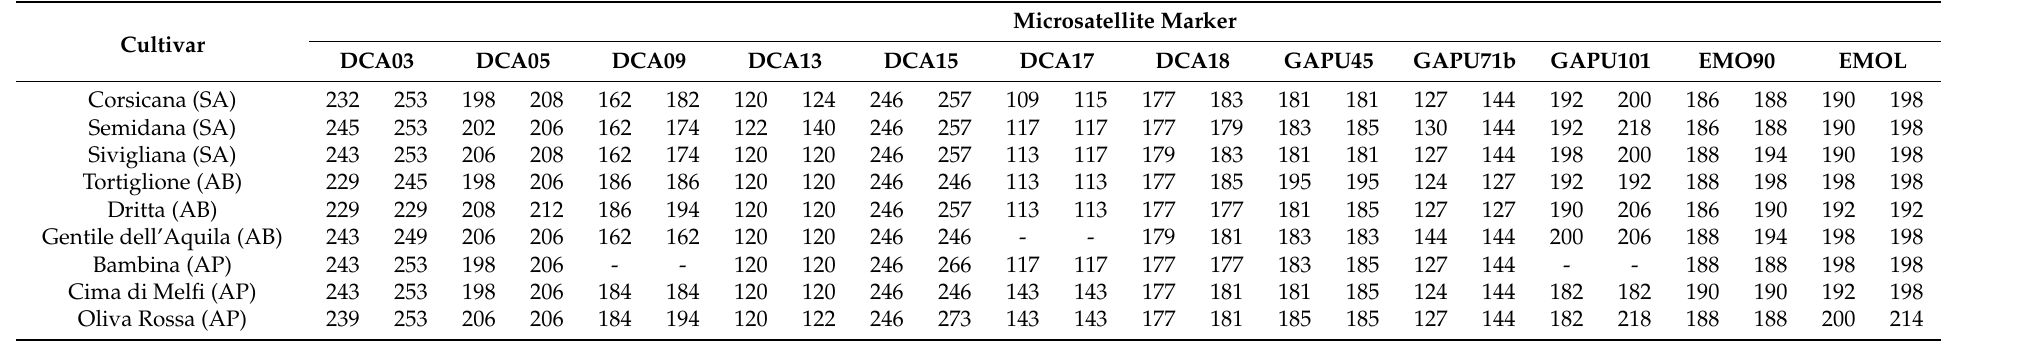
Table 2. Molecular fingerprinting of the analyzed cultivars by means of 12 microsatellite markers (SA, AB and AP, respectively, indicate Sardinian, Abruzzo and Apulian varieties). Allele sizes are reported in base pair